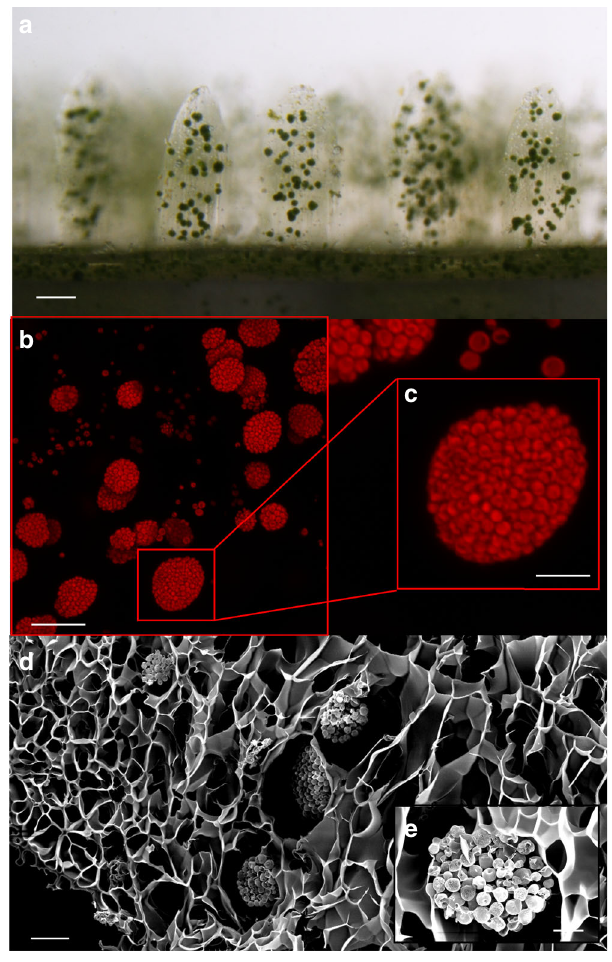
Fig. 4 Living 3D printed bionic coral. Horizontal view of 7-day old bioprinted construct, showing aggregates of the green microalga Marinichlorella kaistiae KAS603 (scale bar = 100 µ m) ( a ). Maximum z projection of confocal images showing chlorophyll a fl uorescence of bionic tentacles (scale bar = 50 µ m) ( b ) and a M. kaistiae KAS603 aggregate (scale bar = 20 µ m) ( c ). SEM image of bionic tissue showing porous tissue scaffolds (scale bar = 20 µ m) ( d ) and a close-up of a microalgal aggregate (scale bar = 10 µ m) ( e